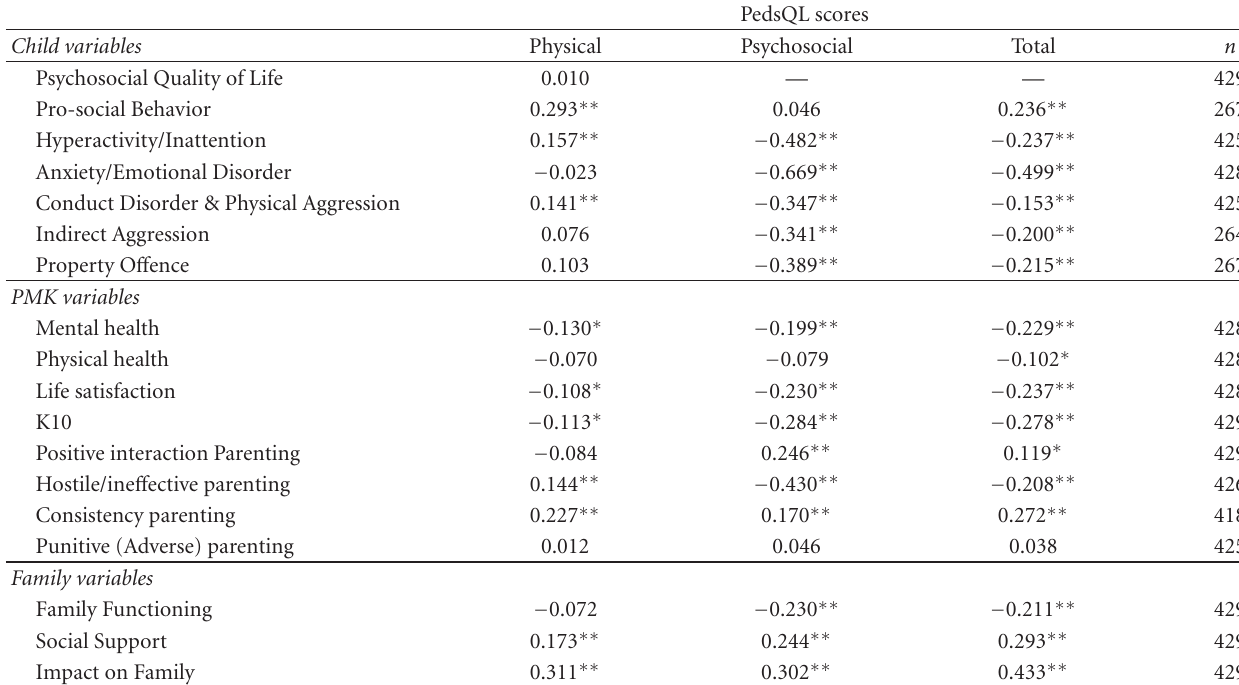
Table 4: Correlations between Quality of Life scores and child/family